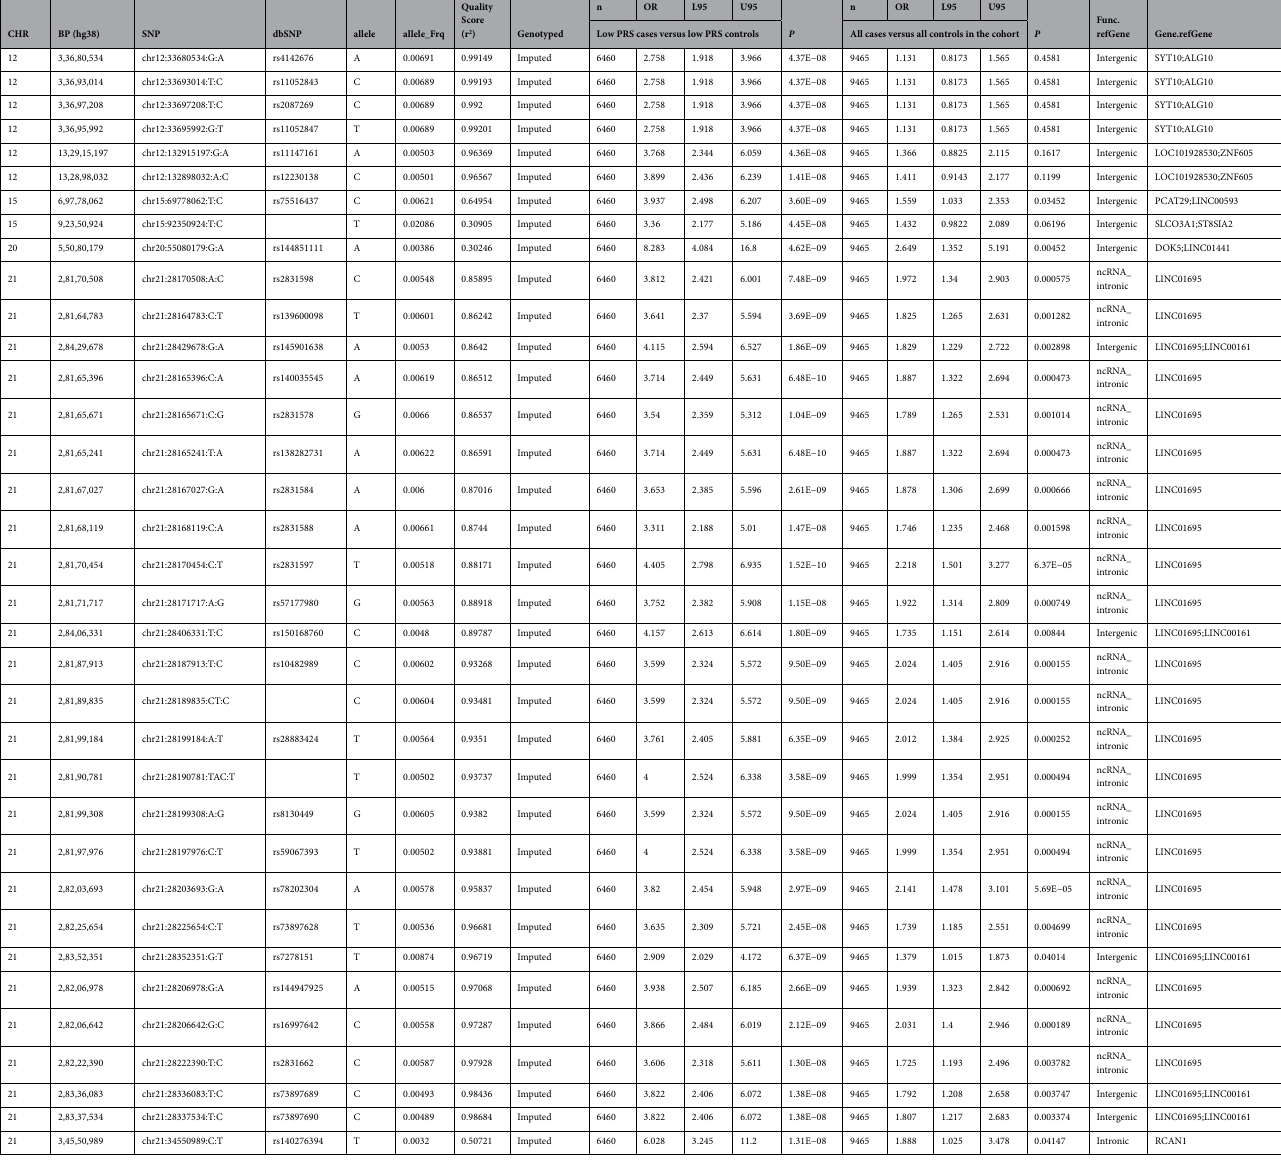
Table 3. Novel loci associated with low PRS